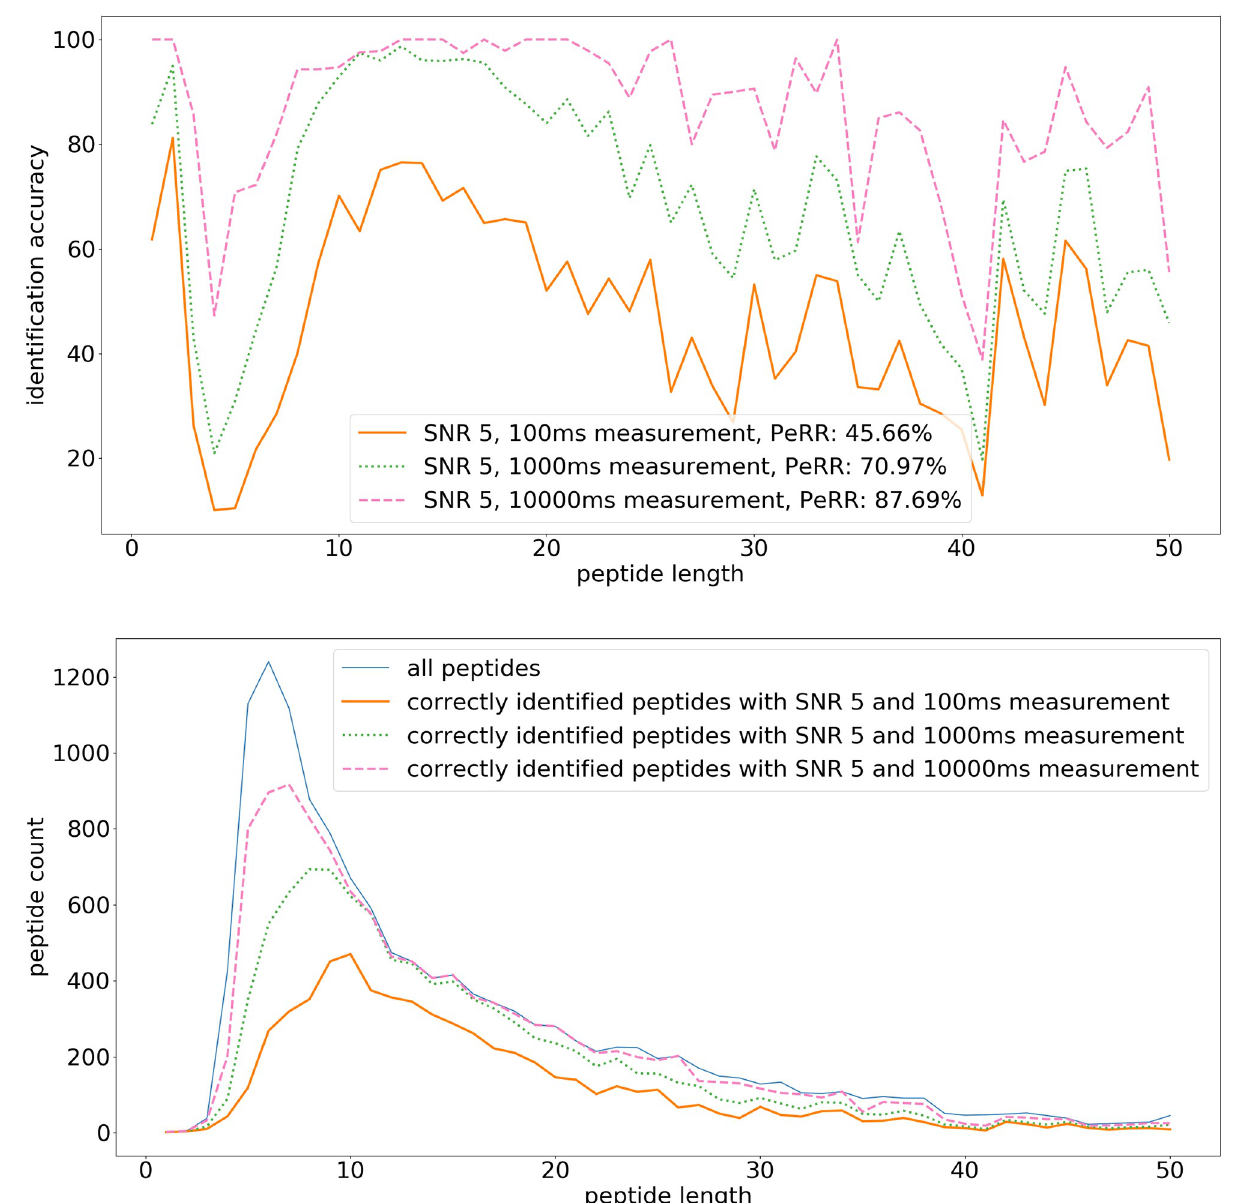
Fig 11. Peptide identification fraction: Initial SNR 5 with long measurement time. (top) The fraction of correctly identified peptides for each peptide length. The legend additionally contains the peptidome recovery rate (PeRR). (bottom) The total peptide count for each peptide length, and the count of correctly identified peptides. The simulation uses the following parameters: pH 2.5, shielding factor exp ð(cid:0) 0 : 2 these simulations the initial SNR is 5 and the measurement times are respectively 100 ms, 1000 ms, and 10 s per amino acid, the other parameters are the same as in the baseline Fig